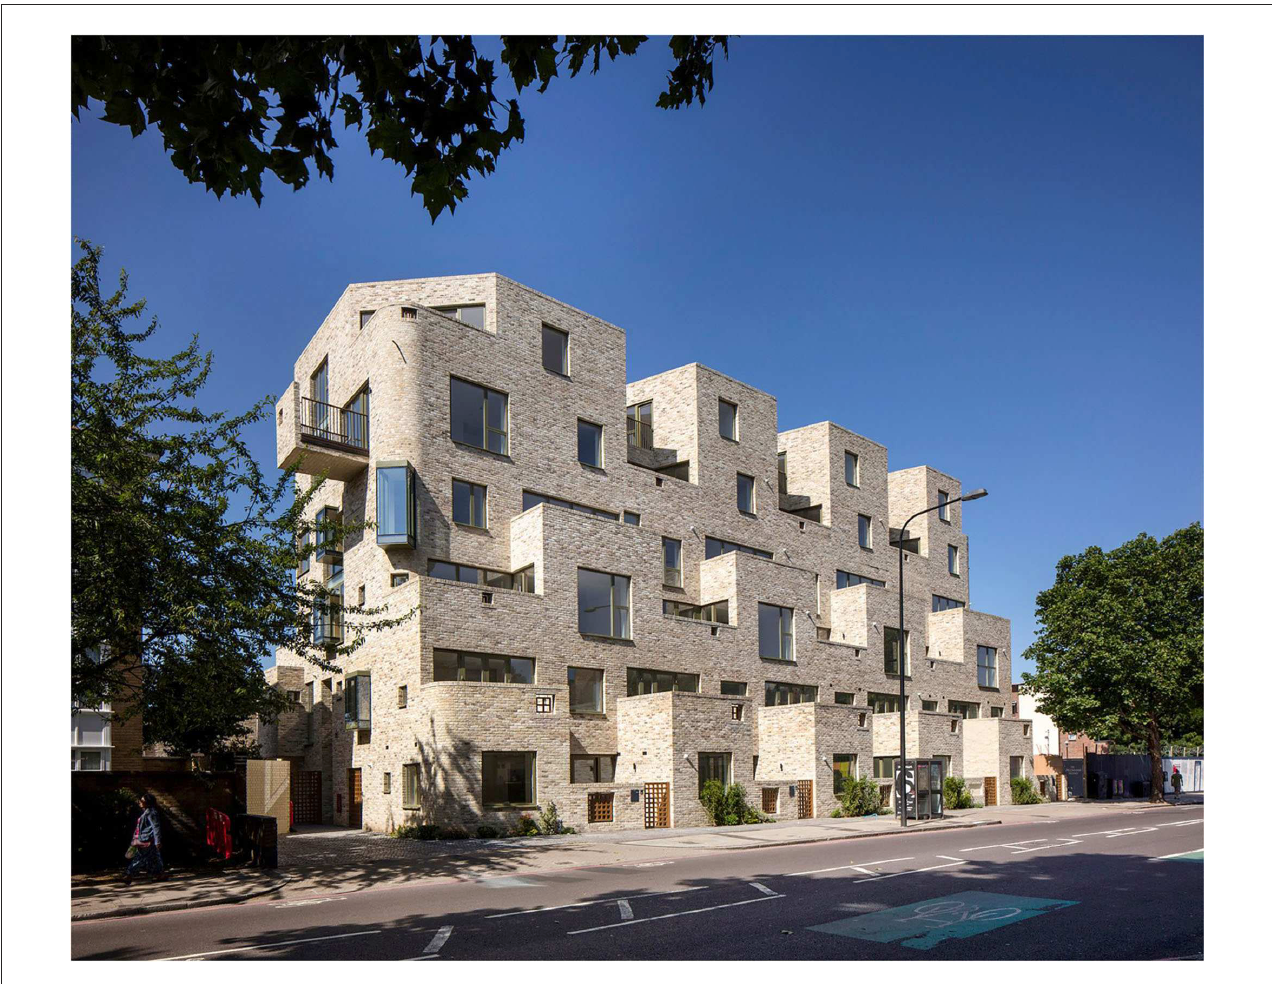
FIGURE2 View of front elevation from Peckham Road (Ravenscroft,